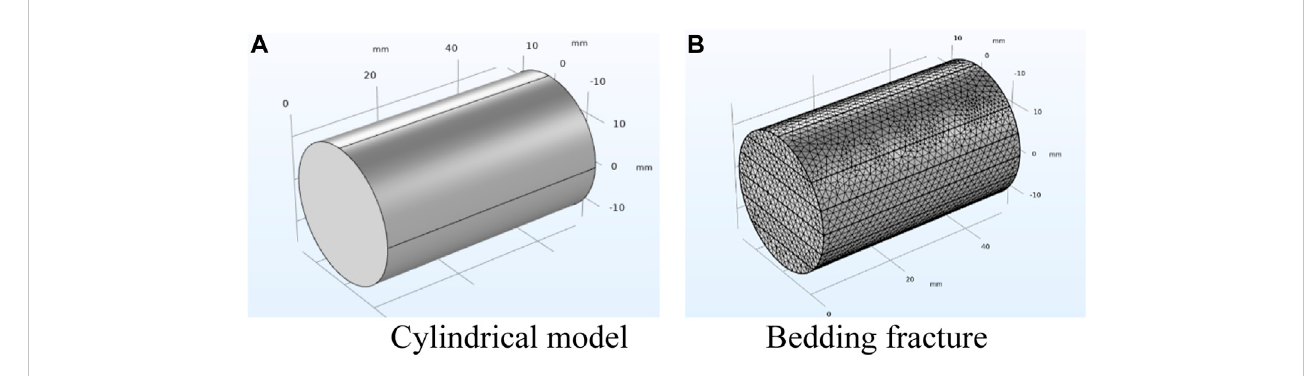
FIGURE 9 Physical model. (A) Cylindrical model; (B) bedding